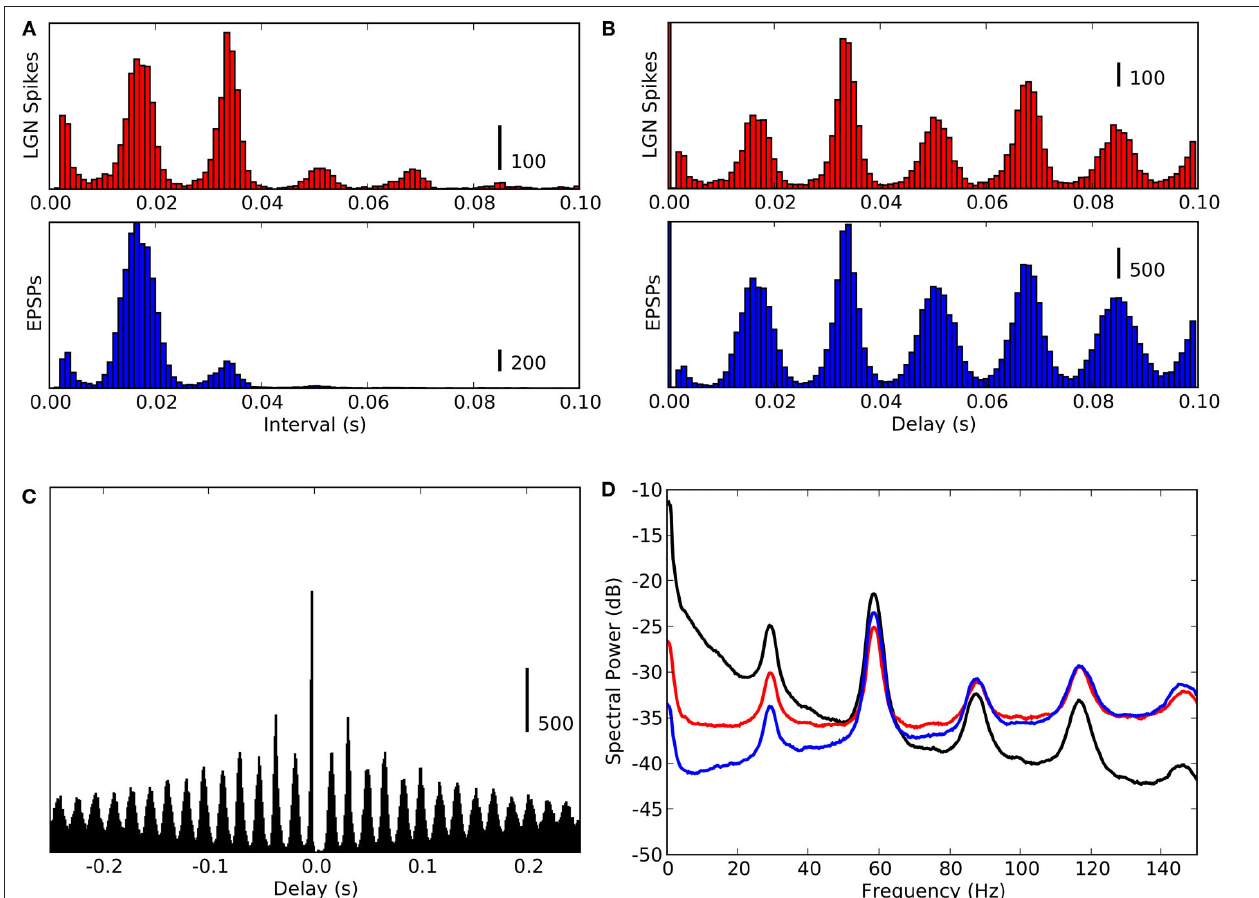
FIGURE 3 | Periodicity in timings of retinogeniculate EPSPs and thalamic spikes. (A) Time-interval histogram for spikes (red, top) and EPSPs (blue, bottom). (B) Autocorrelation histogram for spikes (red, top) and EPSPs (blue, bottom). (C) Cross-correlation histogram between EPSPs and spikes (spike at t = 0). (D) Power spectra of membrane potential (black), spikes (red) and EPSPs (blue), computed with the multi-taper method. All data obtained during stimulation with a natural movie clip (same recording as in Figure 2